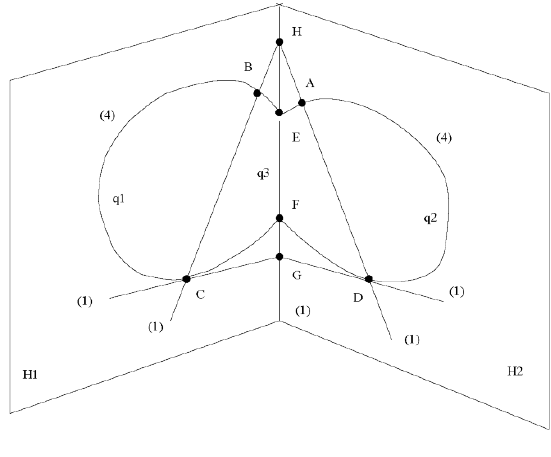
Figure 6. The planes H